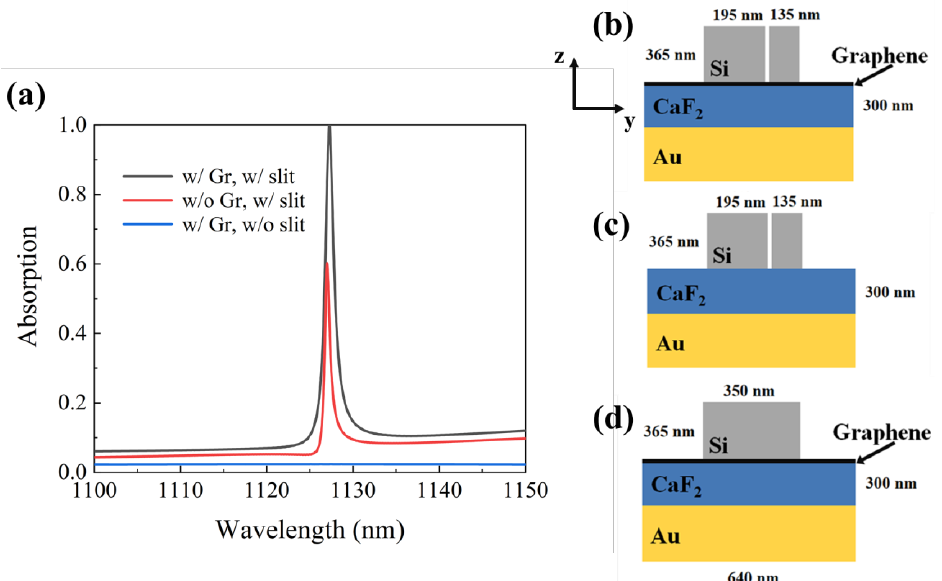
Figure 2. ( a ) Absorption spectrum at normal incidence for TE polarization at three different con- figurations . ( b ) The structure includes monolayer graphene and slit, and the corresponding absorption curve is black. ( c ) The structure does not include monolayer graphene but includes a slit, and the corresponding absorption curve is red. ( d ) The structure includes monolayer graphene but does not include a slit, and the corresponding absorption curve is blue.